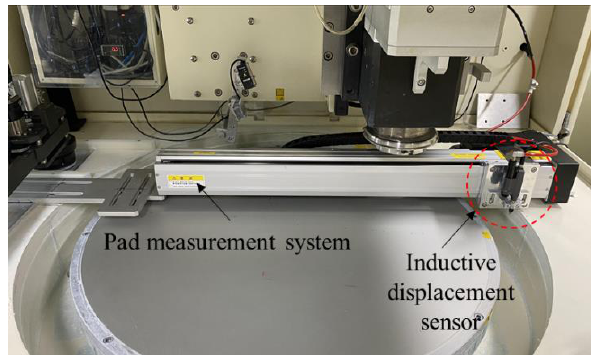
Figure 5. Pad measurement system (PMS, G&P Technology, Busan, Korea).